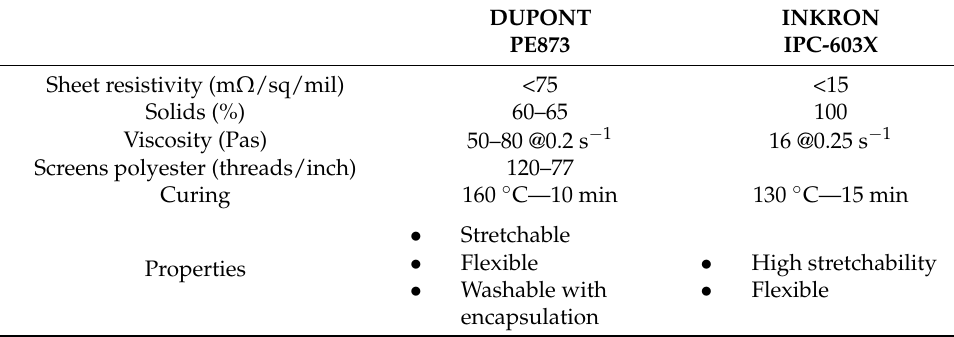
Table 5. Characteristics of the silver